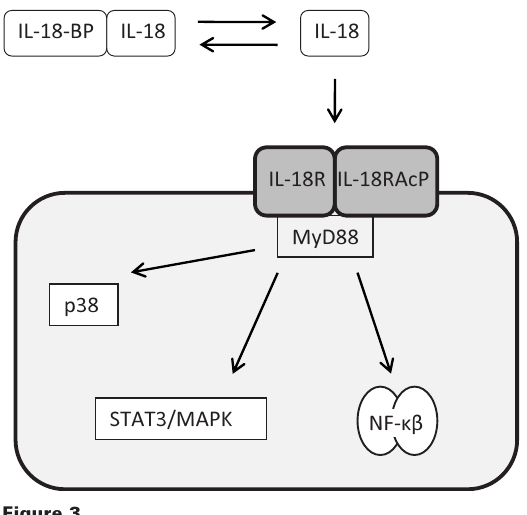
Figure 3 il-18 activation of cell signalling. Binding of il-18 to the il-18R recruits the il-1 receptor activating kinase (iRAk) via the adapter protein myd88. iRAk autophosphorylates and dissociates from the receptor complex, subsequently inter- acting withTNFR-associated factor 6 (TRAF6) which relays the signal to the i kb kinases (ikks) leading to the release and translocation to the nucleus of NF- kb . Alternatively il-18 binding to the il-18R complex can activate the mitogen-acti- vated protein kinase (MAPk) p38, JNk and eRk through both iRAk and